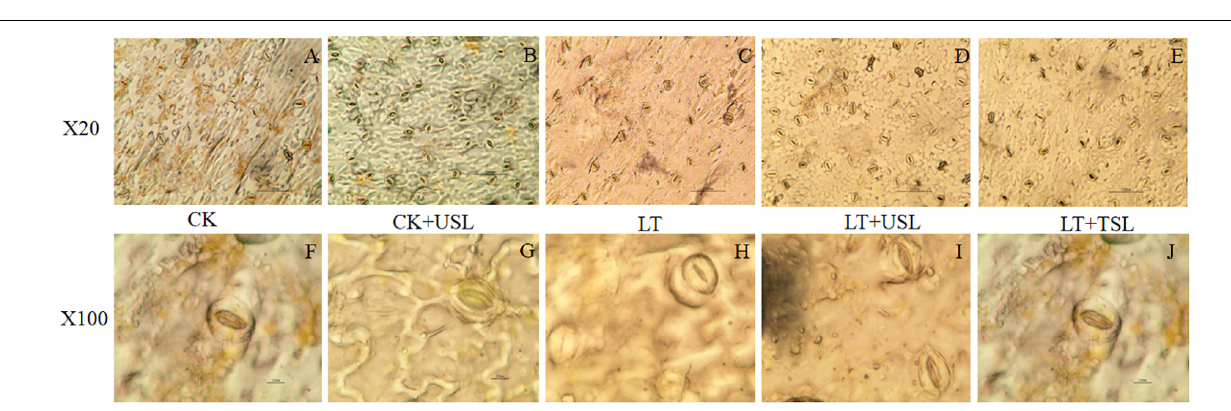
FIGURE 6 | Effects of USL on the stomatal morphology of tomato leaves under LT stress. (A–E,F–J) are the stomatal morphology observed under 20 and 100X objective lenses,